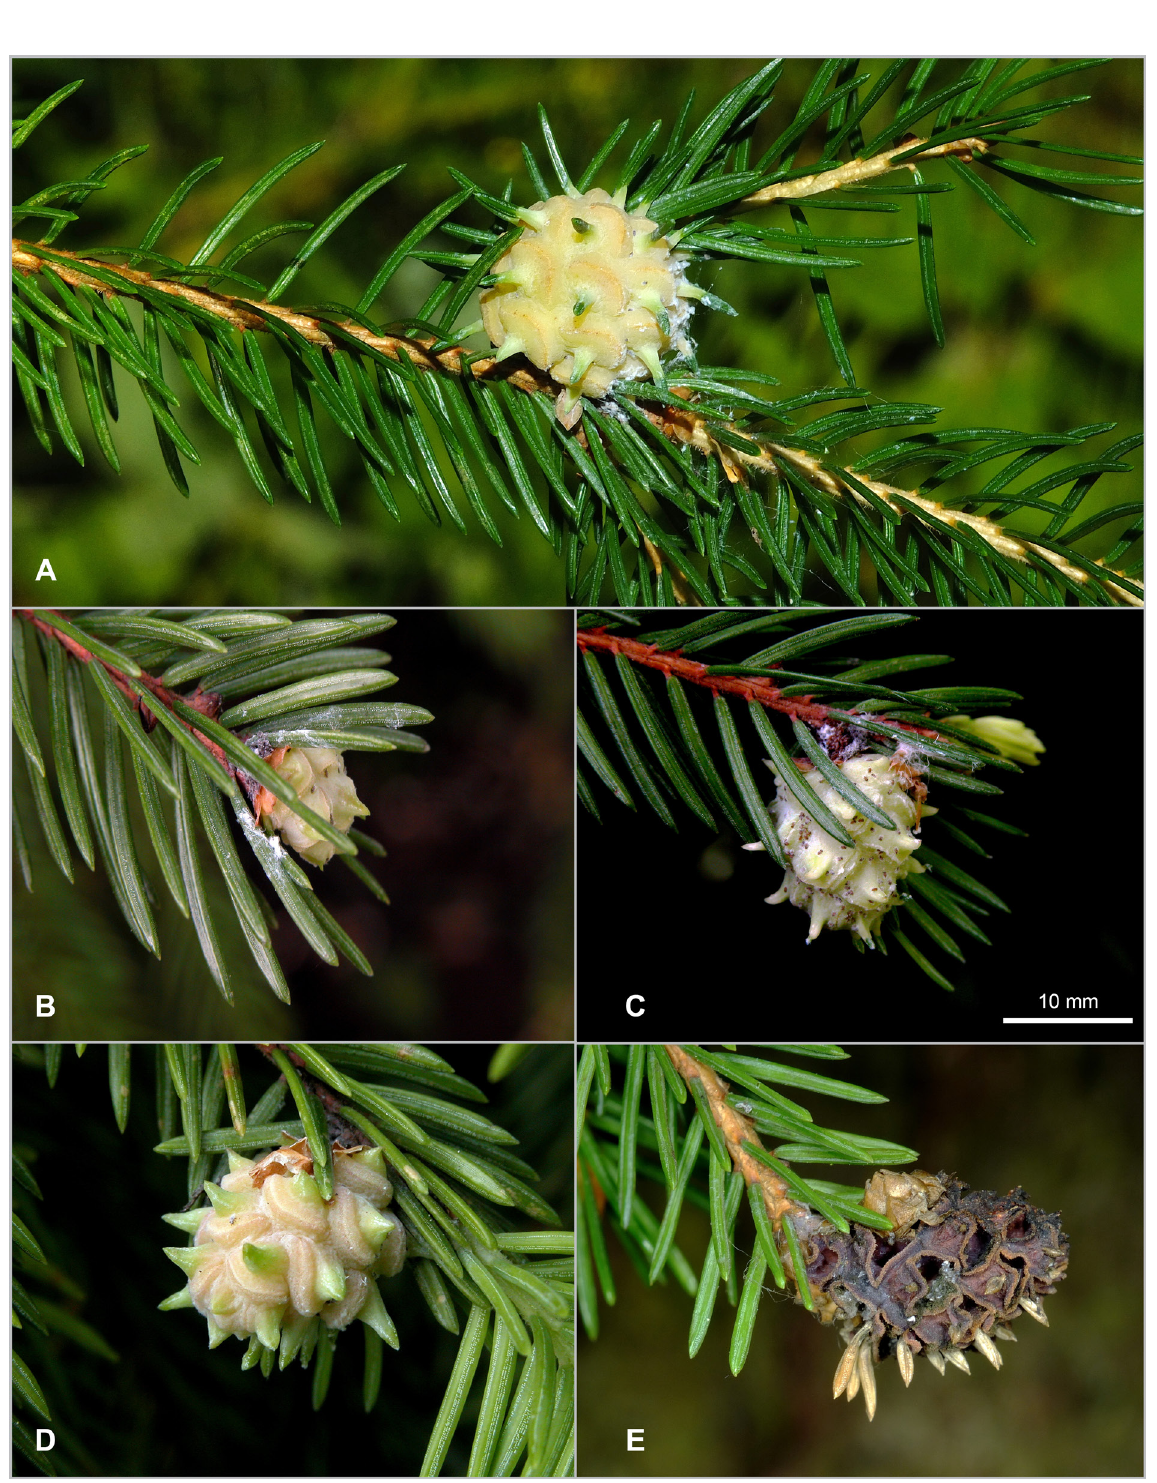
Fig. 8. Adelges (Adelges) laricis Vallot, 1836. Galls on Picea abies . A , D . Almost mature. B . Young. C . Half-grown. E . Abandoned gall (in